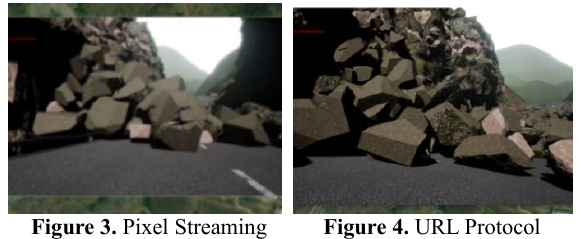
Figure 3. Pixel Streaming Figure 4. URL Protocol